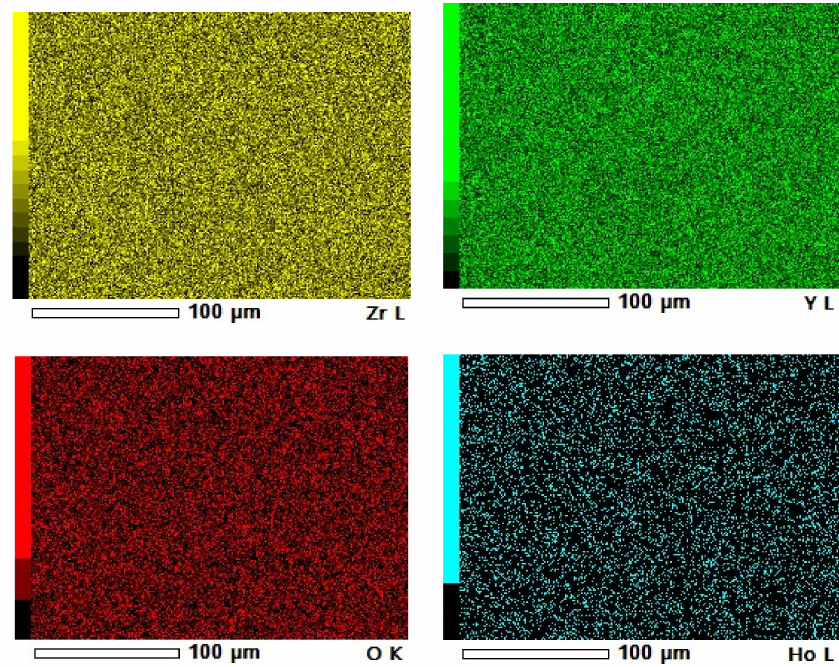
Figure 2. EDS image of the (ZrO 2 ) 90 (Y 2 O 3 ) 9.25 (Ho 2 O 3 ) 0.75 sample.